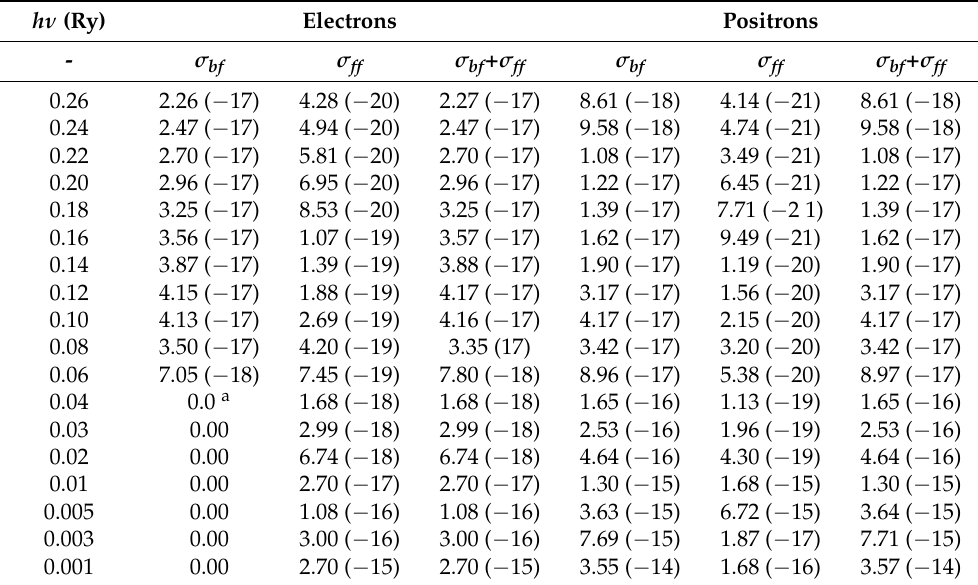
Table 15. Comparison of bound-free ( σ bf ) and free-free ( σ f f ) cross sections (cm 2 ) for electrons and positrons, T = 6300 K.